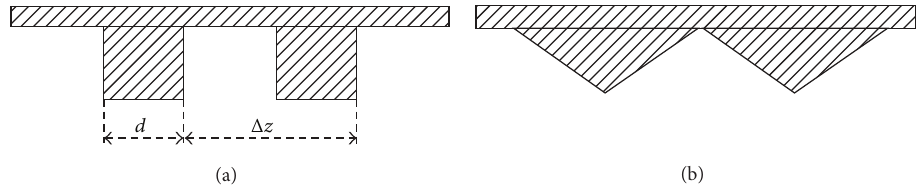
Figure 4: Schematic view of typical obstacle shape discussed in ICDERS-2007 [24].